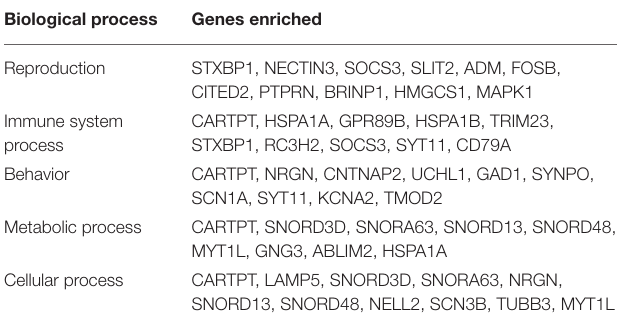
TABLE 7 | The GO biological process enriched in the DEGs in all the comparison groups. Biological process